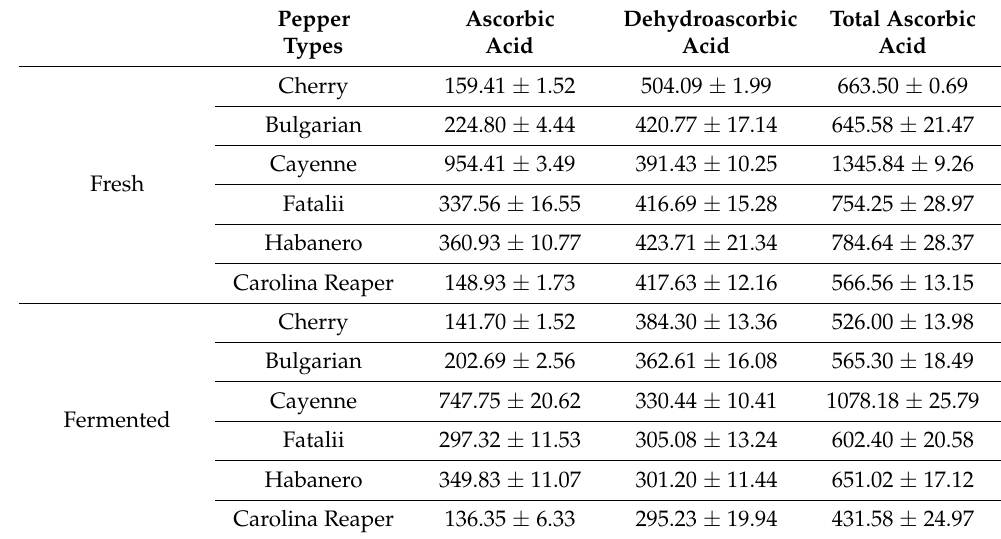
Table 5. Average values for ascorbic acid content in different pepper samples ( µ